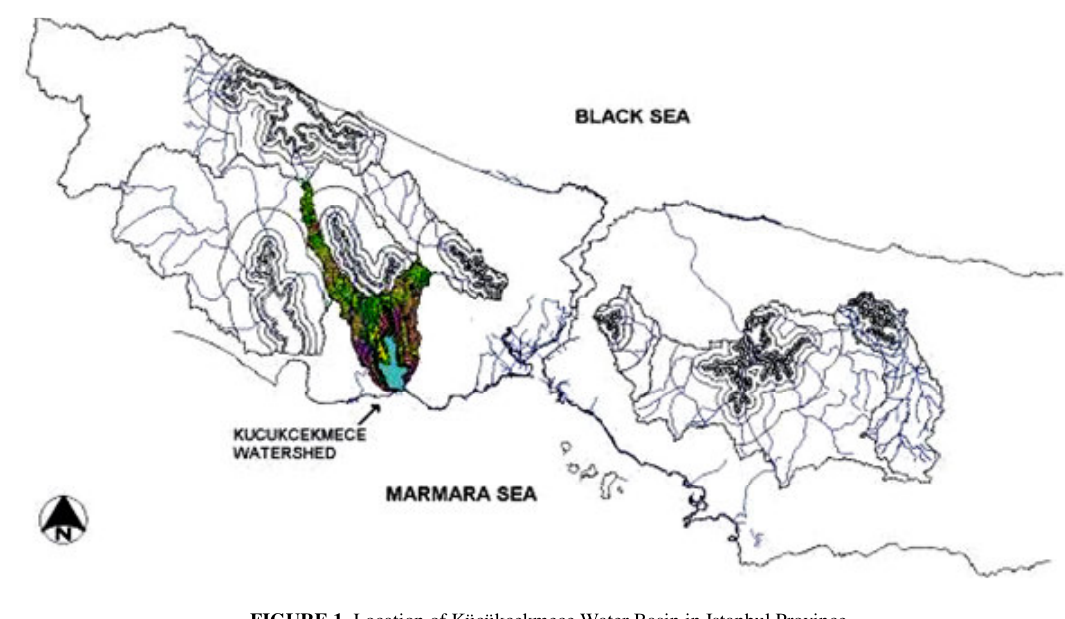
FIGURE 1 . Location of Küçükçekmece Water Basin in Istanbul